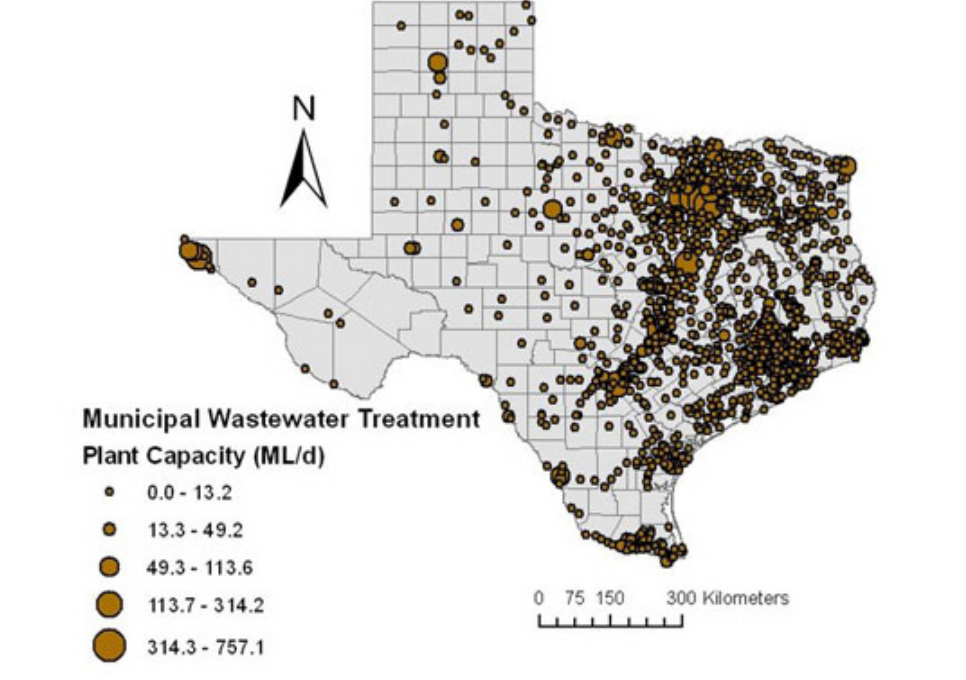
Fig. 6 . Municipal wastewater treatment flow for Texas wastewater treatment plants (Environmental Protection Agency 2008, Texas Commission on Environmental Quality 2008). More than 76% of the wastewater treatment plants in Texas are small, using less than 3.8 megaliters per day